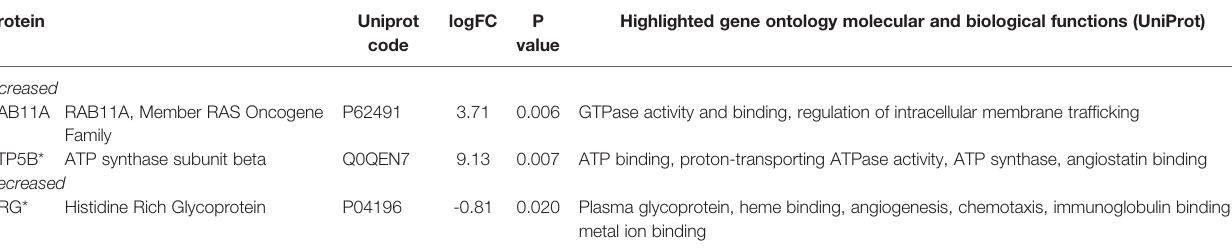
logFC P Highlighted gene ontology molecular and biological functions (UniProt) code value